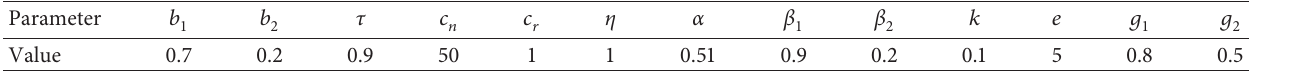
Table 2: Table of basic data.